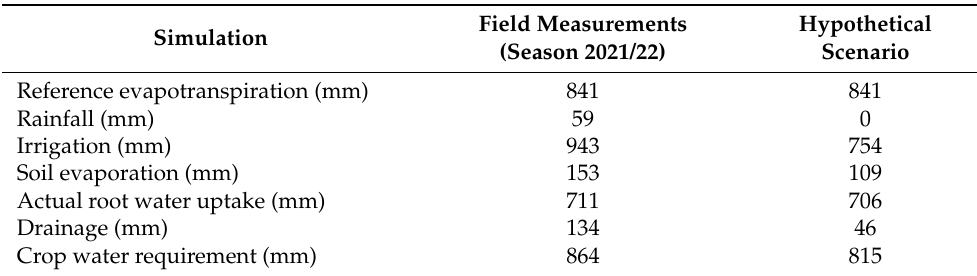
Figure 4. HYDRUS-2D simulations of daily volumetric soil water content ( top graph) and AquaCheck probe measurements ( bottom graph) in the African Delight plum orchard in Robertson. Data refer to simulations/measurements at two soil depths within the tree row. Table 2. Seasonal reference evapotranspiration, water balance components (rainfall, irrigation, soil evaporation, actual root water uptake and free drainage) and crop water requirements for the plum